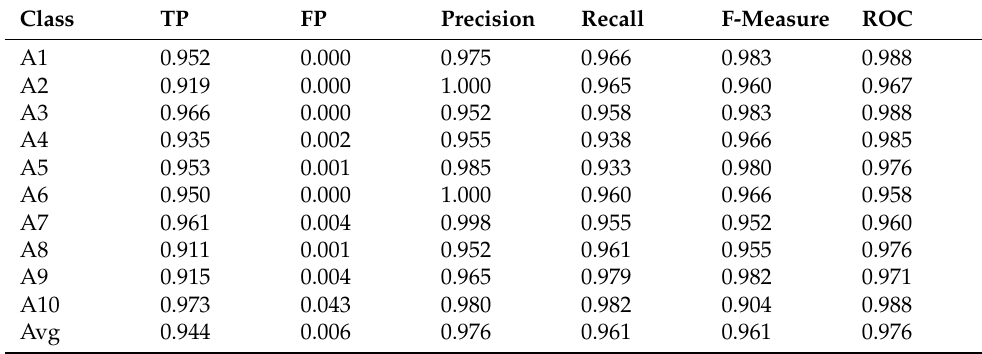
Table 9. SVM classification